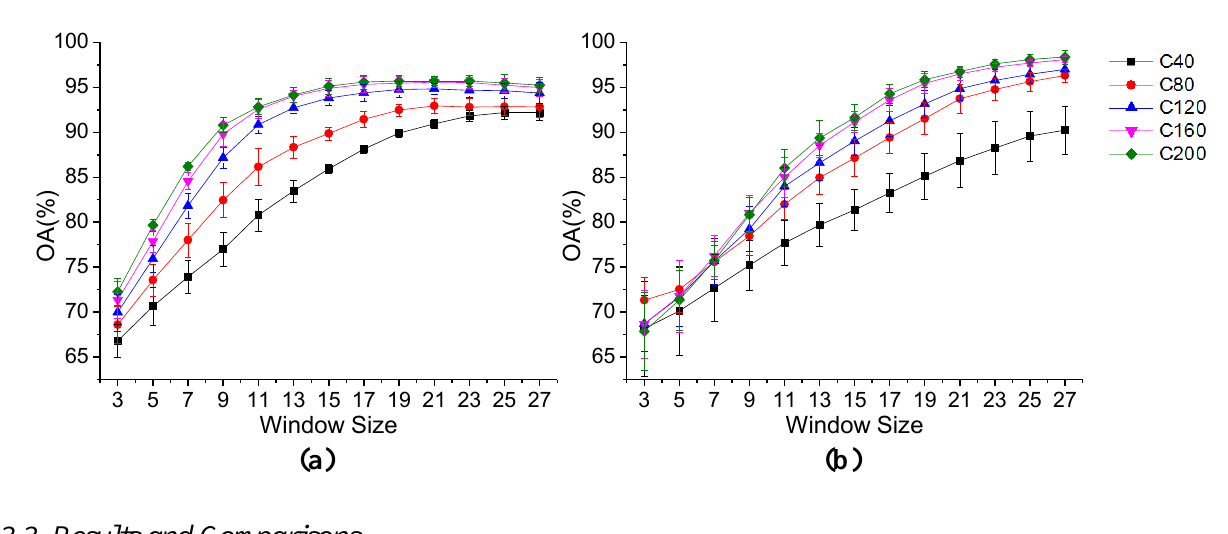
Figure 8. Classification accuracies of the proposed algorithm with different window sizes (3, 11, 19, 27, and multiscale) for: ( a ) the Indian Pines image; and ( b ) the Pavia University